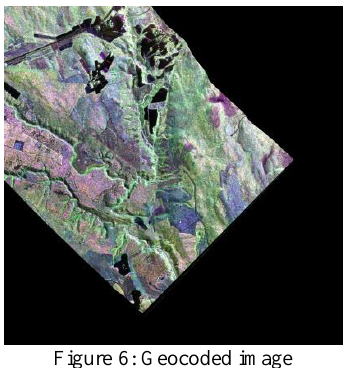
Figure 6: Geocoded image Number of plots which was used for evaluation of the results was about 36.